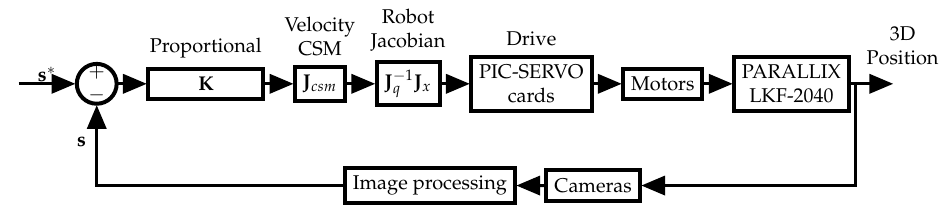
Figure 2. Block diagram of the proposed control